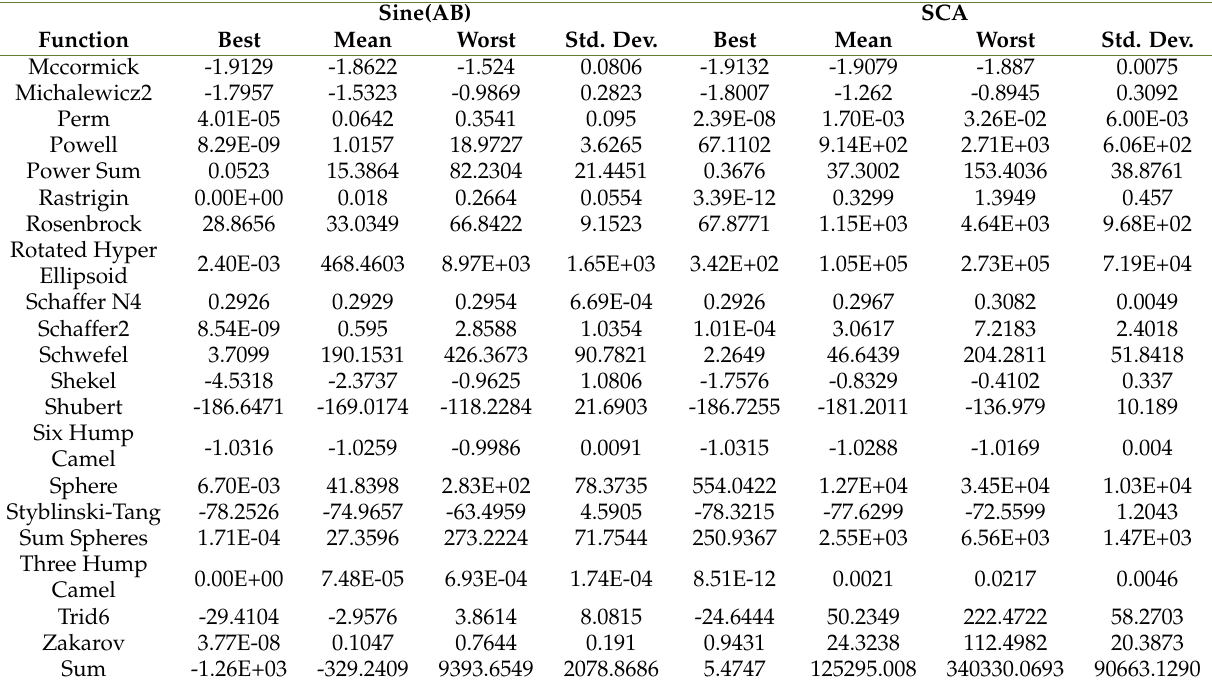
Table 5. Results of a = 1 (2 for